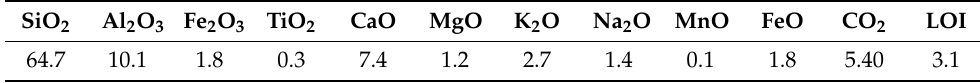
Table 2. Parameter of modifier solution.